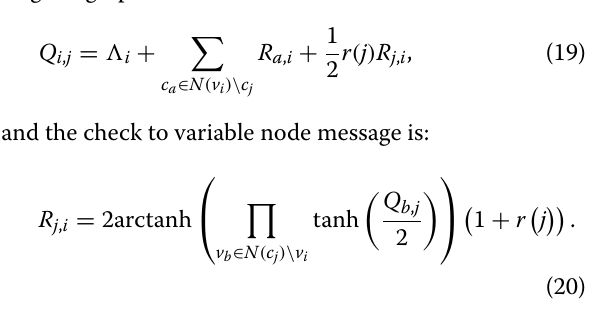
As the duplicated rows in each candidate are selected randomly, it is possible to generate candidates as they are required. Furthermore, it is possible to vary the augmenta- tion density depending on SNR. Section 4.1